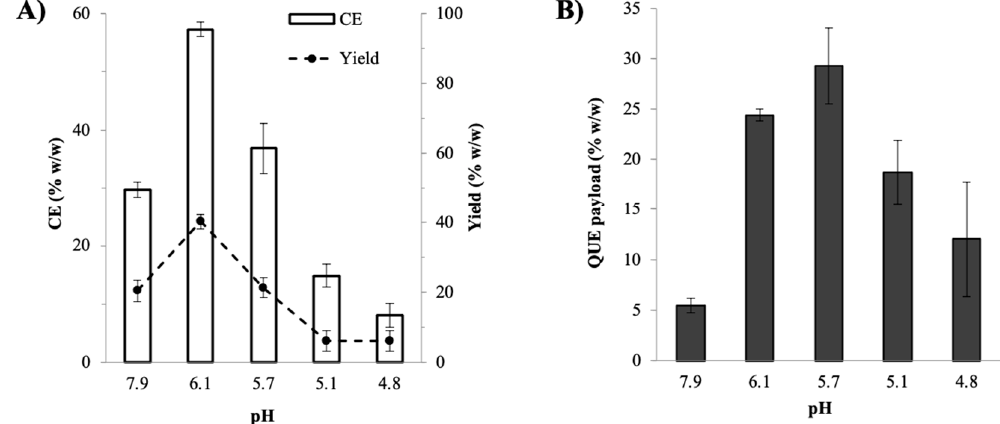
Figure 3. Effect of pH on ( A ) complexation efficiency (CE), yield and ( B ) QUE payload of the QUE–CHI nanoplex.